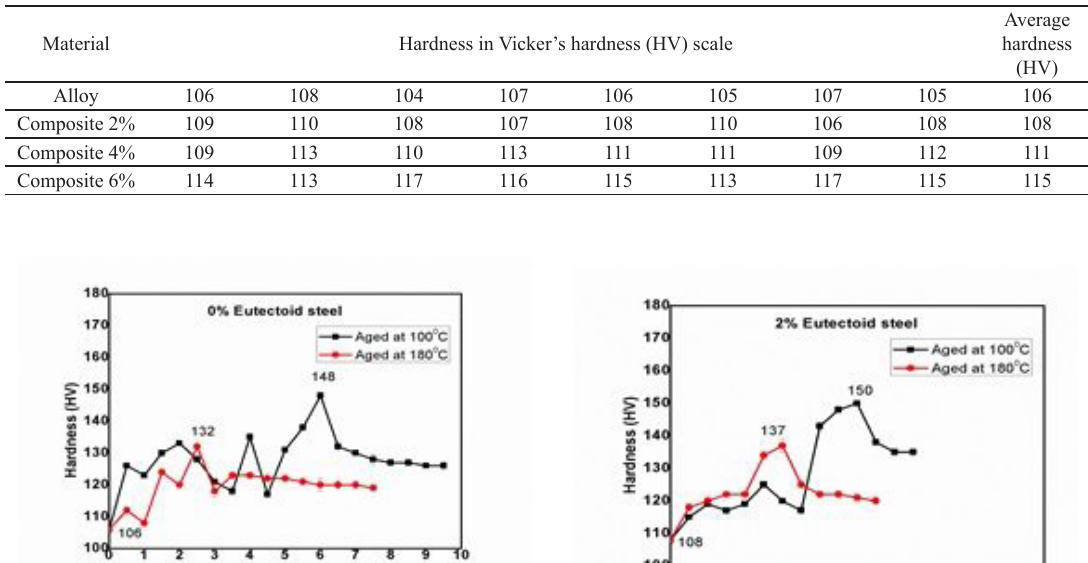
Table 4. Solutionised hardness of alloy and composites.